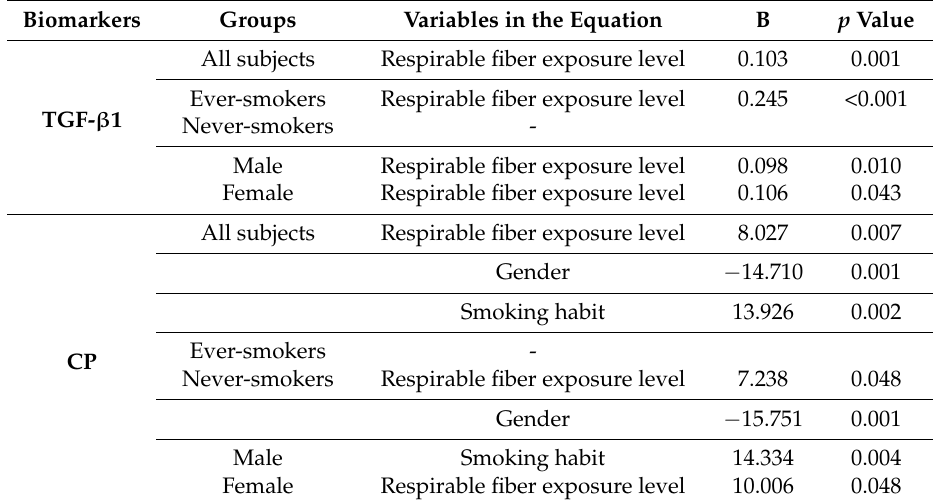
Table 3. Influence factors of biomarkers analyzed by multiple linear